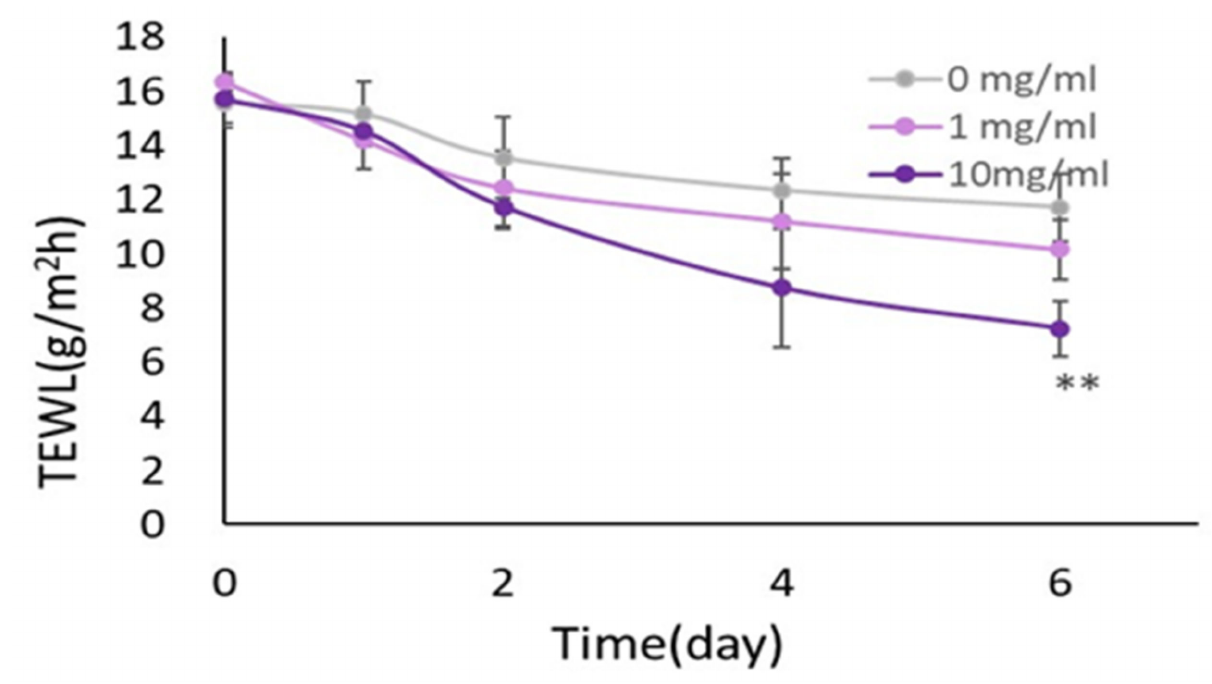
Figure 5. Effect of HC on the skin barrier function in RHEEs by TEWL analysis. RHEEs were treated with HC (at 0, 1 and 10 mg/mL) and were incubated for 6 days, and TEWL was measured at days 0, 1, 2, 4 and 6 of culturing as described in Section 4 Materials and Methods. During that period, the medium and samples were replaced every other day. Data represent the mean ± SD; n = 4. ** p < 0.01 vs.